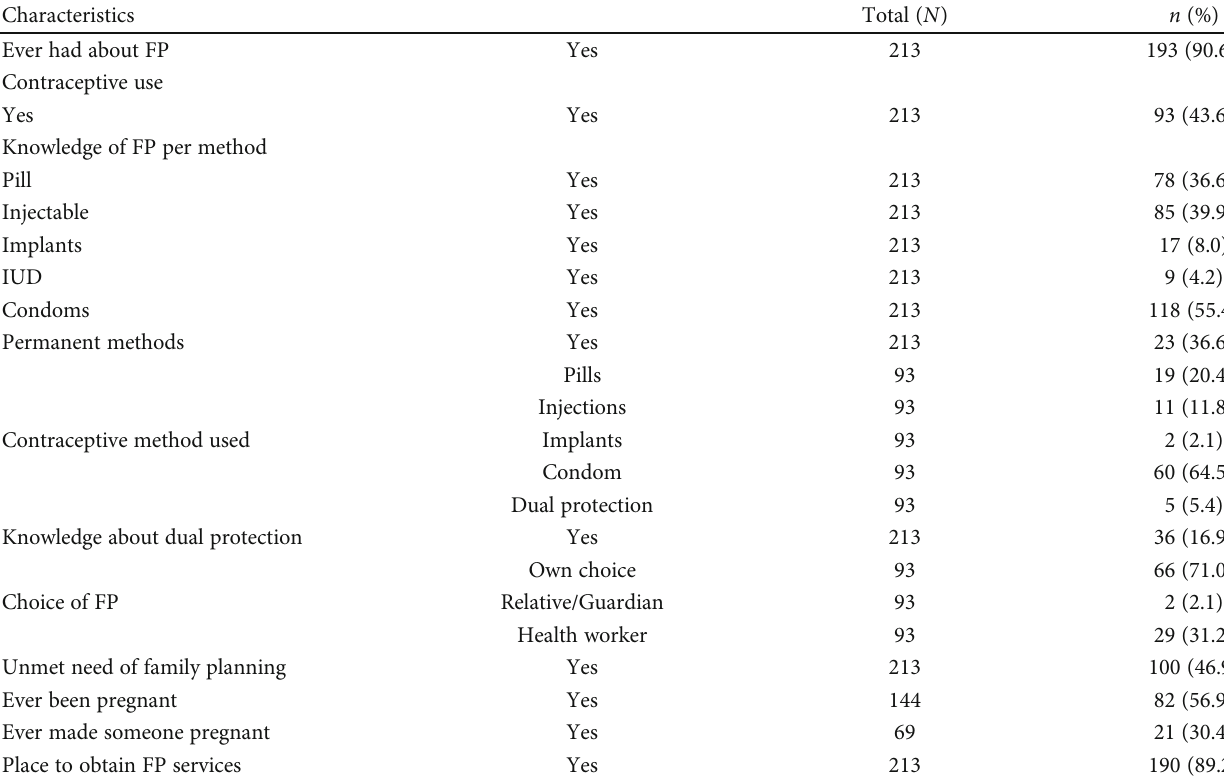
Table 2: Family planning use among sexually active HIV perinatally infected